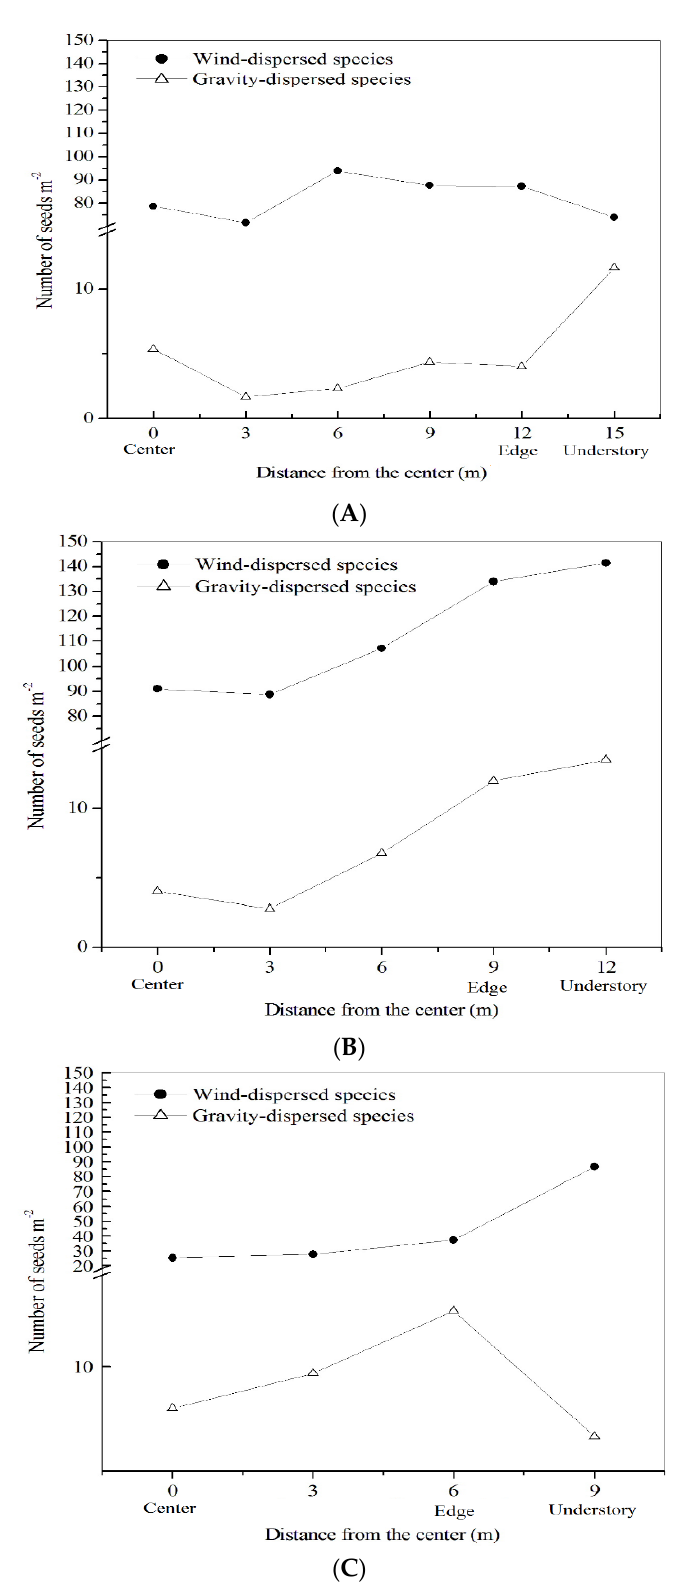
Figure 3. Spatial distribution patterns of the seed rain density for two main types of seed dispersal (i.e., gravity-dispersed species and wind-dispersed species) in large gaps ( A ), medium gaps ( B ), and small gaps ( C ) shown as the mean value for three years. Among the three sizes of gaps, the seed densities were the highest in the medium gaps ( p = 0.03) for all of the woody species (105 ± 14 seeds/m 2 ) and wind-dispersed tree species (98 ± 6 seeds/m 2 ).